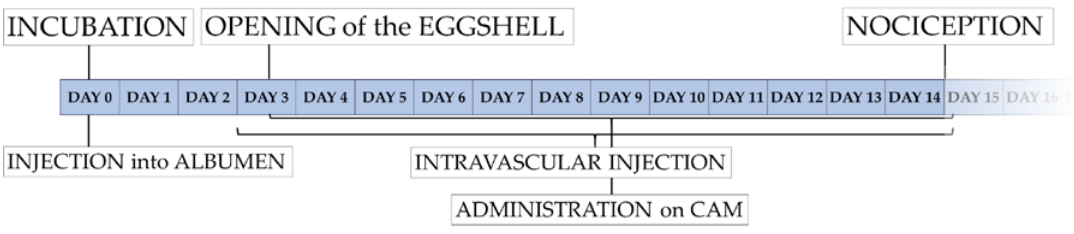
Figure 2. Timeline of experimentation with the CAM assay in ovo method.